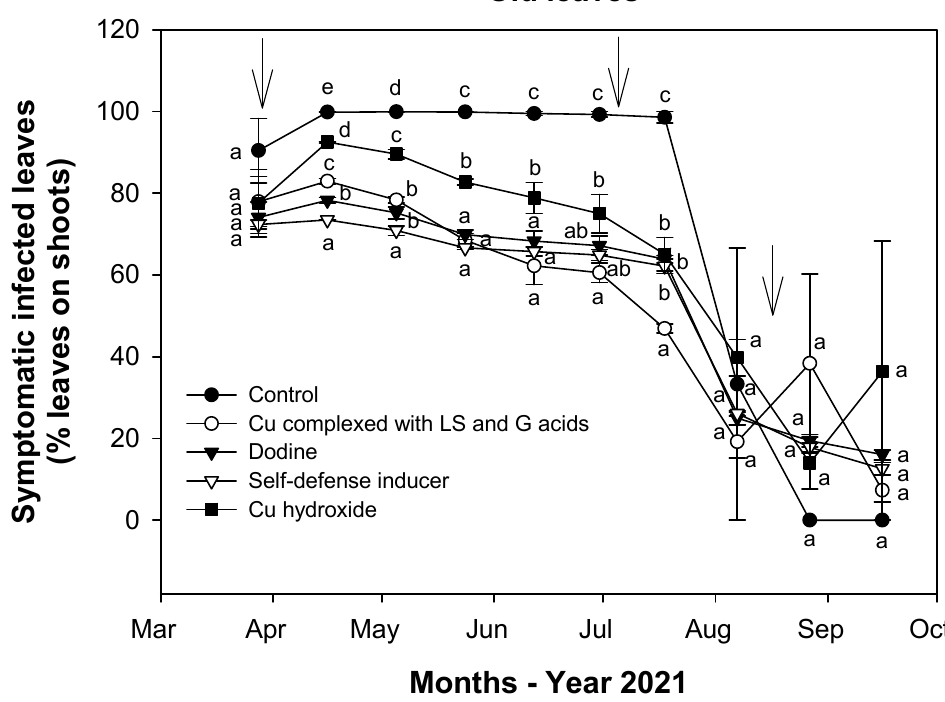
Figure 2. Effect of chemical treatments on symptomatic Venturia oleaginea infection in old leaves (grown in 2020). Arrows indicate the dates of fungicide application. Bars represent the standard error. For each date, means followed by different letters are significantly different at p ≤ 0.05.